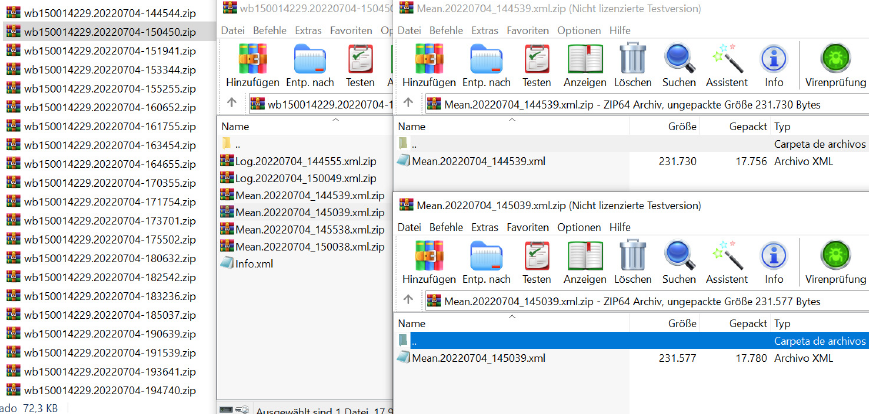
Figure 1. Organisation and format of the files corresponding to the monitoring of a sector of a PV plant during some hours of a specific day.